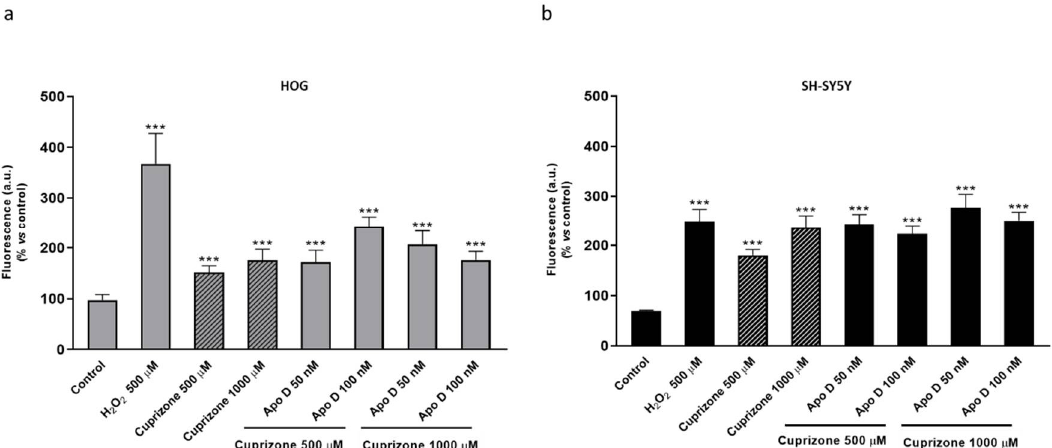
Figure 11. ROS production in HOG ( a ) and SH-SY5Y cells ( b ) treated with increasing concentrations (50–100 nM) of hApo D for 24 h followed by 24 h with 500 or 1000 µM of CPZ. Changes in ROS levels, measured with the oxidant-sensitive dye